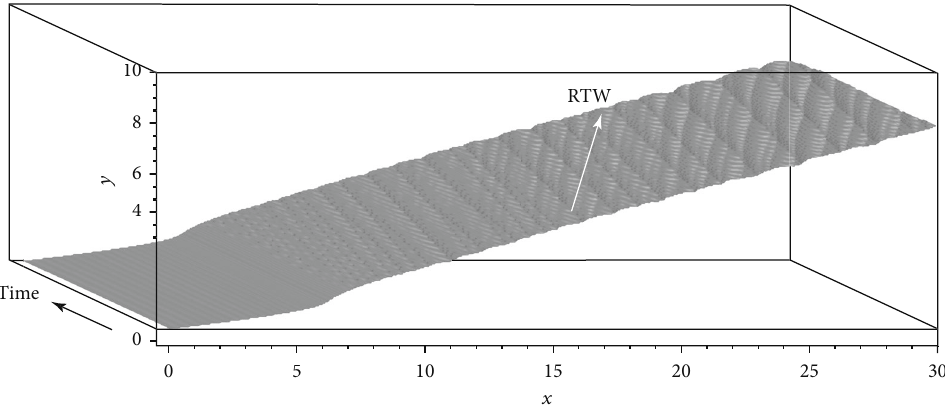
Figure 13: Numerical smoke foil shows the evolution of the RTW in Figure